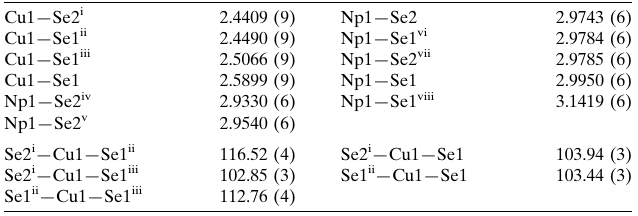
Selected geometric parameters (A˚ , (cid:2)